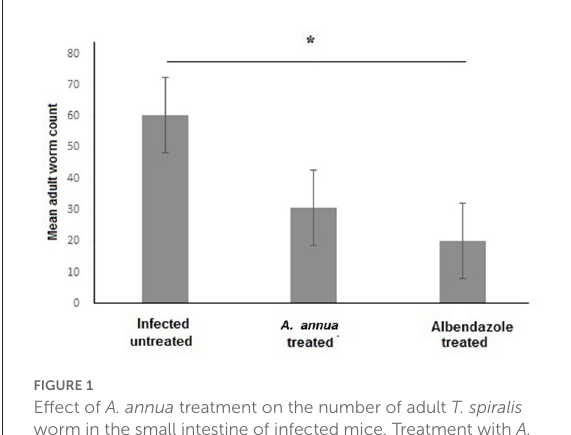
FIGURE1 Effect of A. annua treatment on the number of adult T. spiralis worm in the small intestine of infected mice. Treatment with A. annua extract significantly reduced worm count in the intestine of infected mice, an effect that was comparable to albendazole (positive control). Data are expressed as mean ± SD ( N = 10) and analyzed by using ANOVA followed by LSD as a post hoc test. Asterisk (*) indicate significant difference; p <